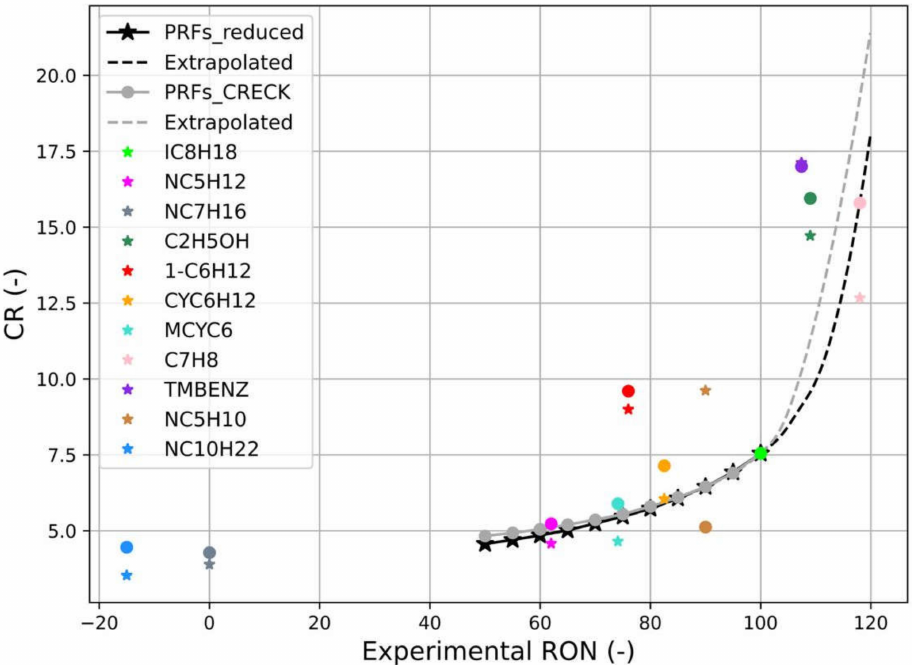
Figure 6. Correlation between calculated CR at knock conditions and experimental RON for PRFs and pure species performed with the complete (points) and reduced (stars) kinetics schemes. P , T input from engine model; method: Cantera reactor